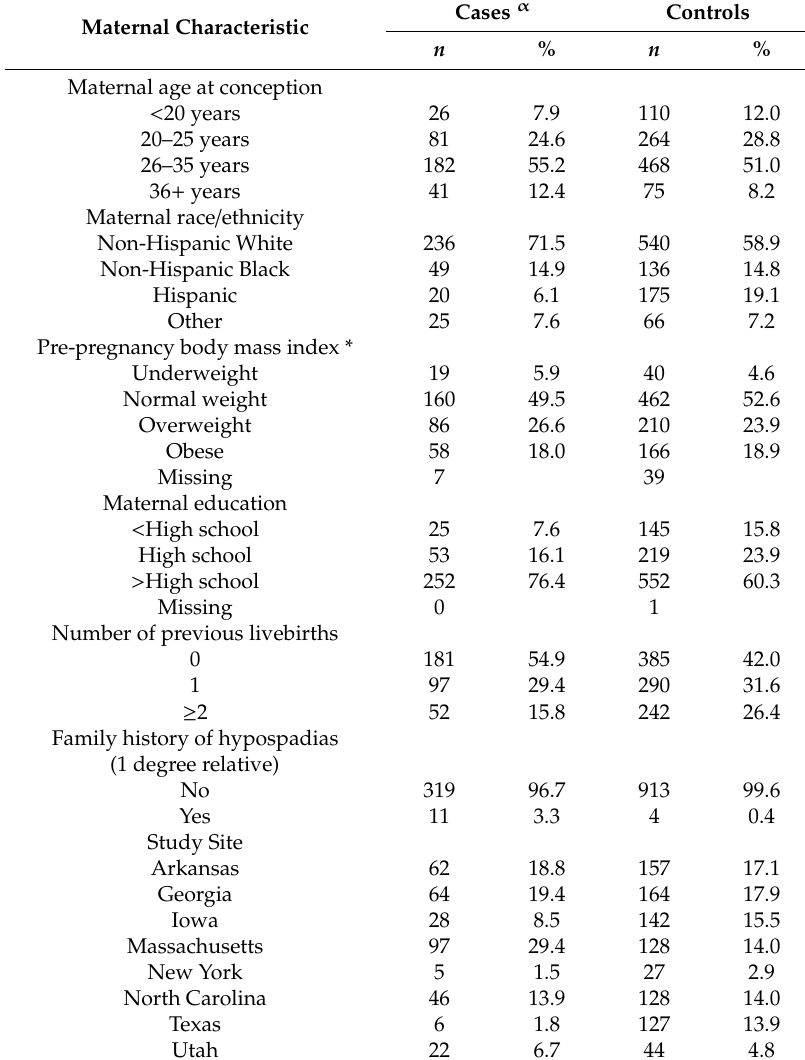
Table 1. Distribution of maternal characteristics among hypospadias cases and controls, National Birth Defects Prevention Study, 2000–2005 ( n =